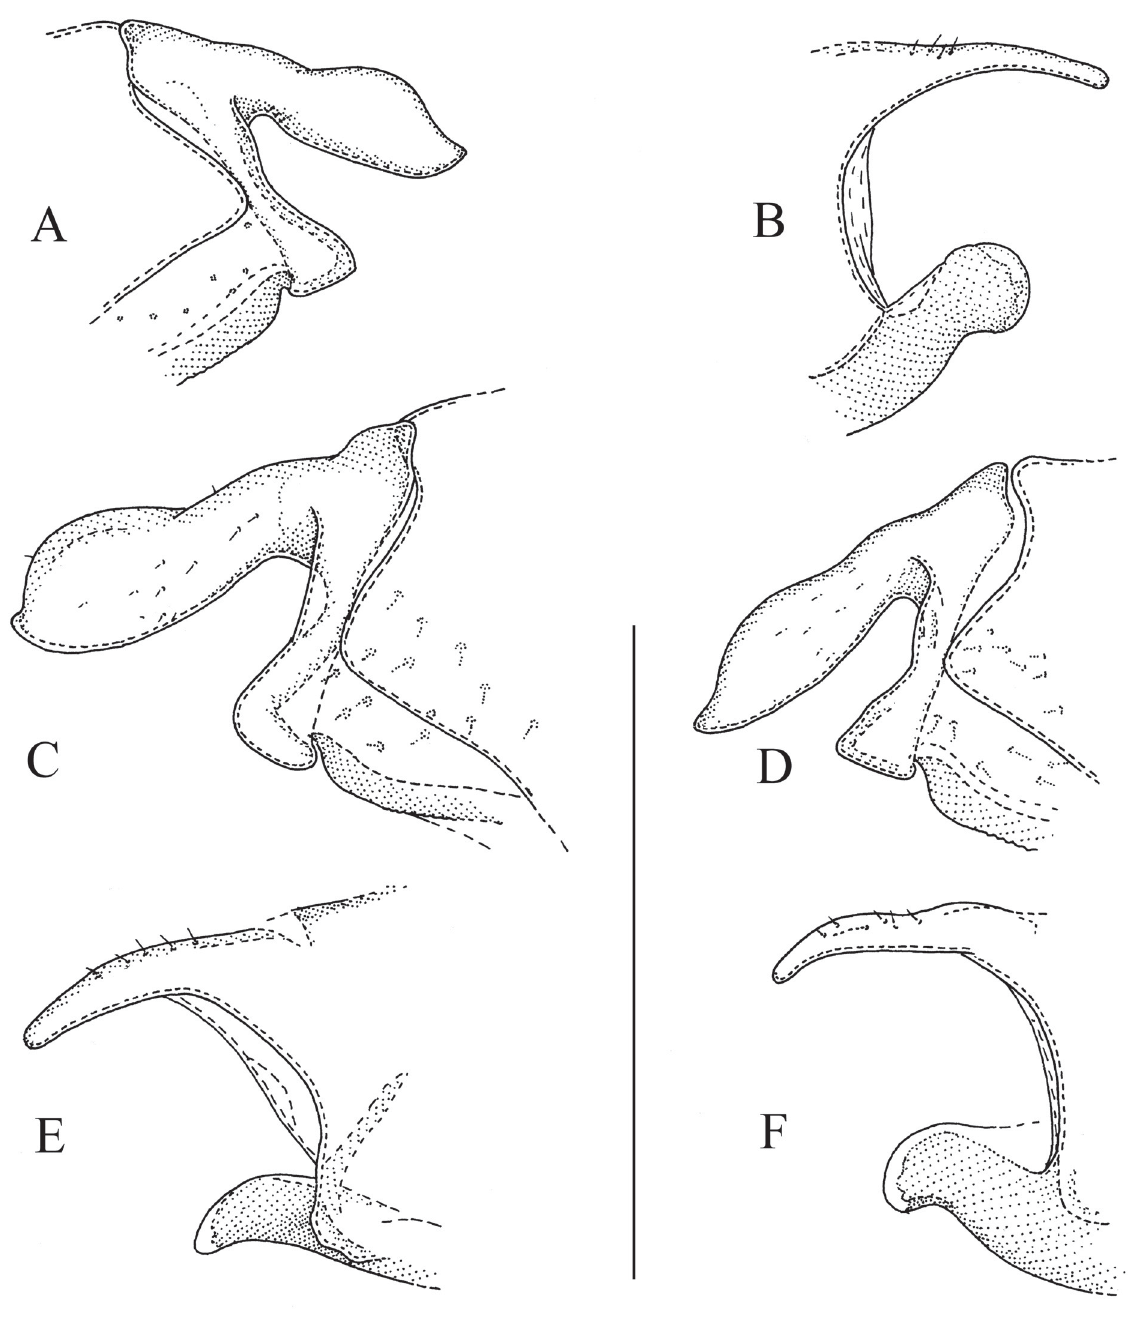
Fig. 69. Sphegina (Asiosphegina) orient alis Kertész, 1914, male genitalia, China, Mt Emei (A–B, D, F) and Taiwan specimens 1, Mingchih (C, E). A . Left surstylus with associated parts, lateral view. B . Left superior lobe with associated parts, lateral view. C–D . Right surstylus with associated parts, lateral view. E–F . Right superior lobe with associated parts, lateral view. Sale bar=